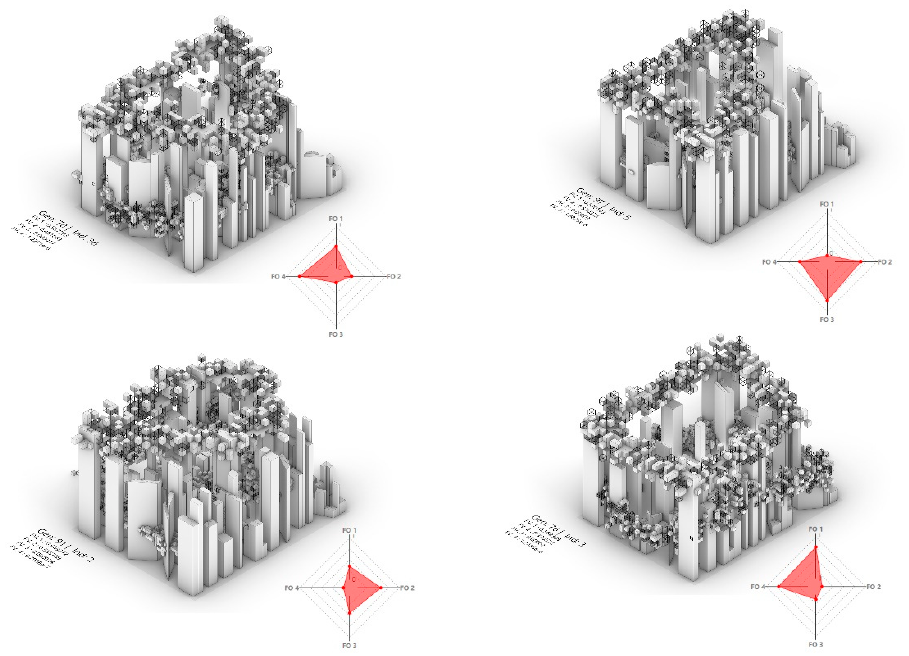
Figure 17. The fittest solution for each fitness function (outliers) alongside each solution’s respective diamond chart.